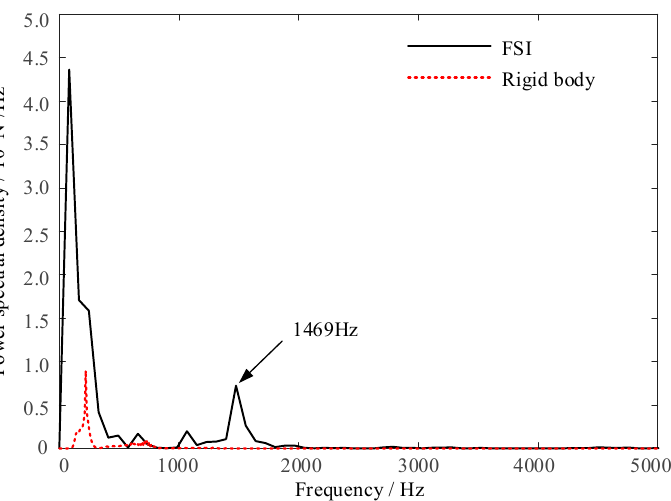
Figure 13. Frequency characteristics of the hydrodynamic force of elastic and rigid supercavitating projectiles.